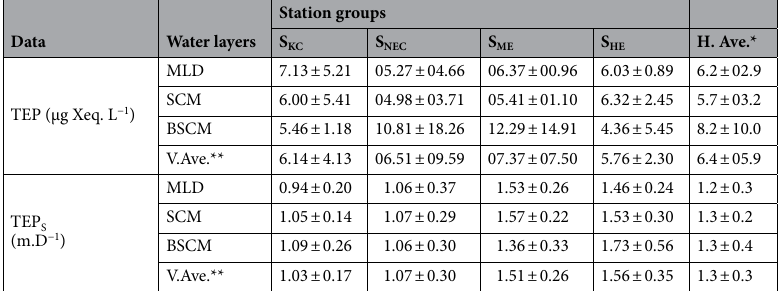
Table 1. Variations in the average TEP concentrations and sinking rates with standard deviations across different sea regions during the study. *Horizontal average, **Vertical average.